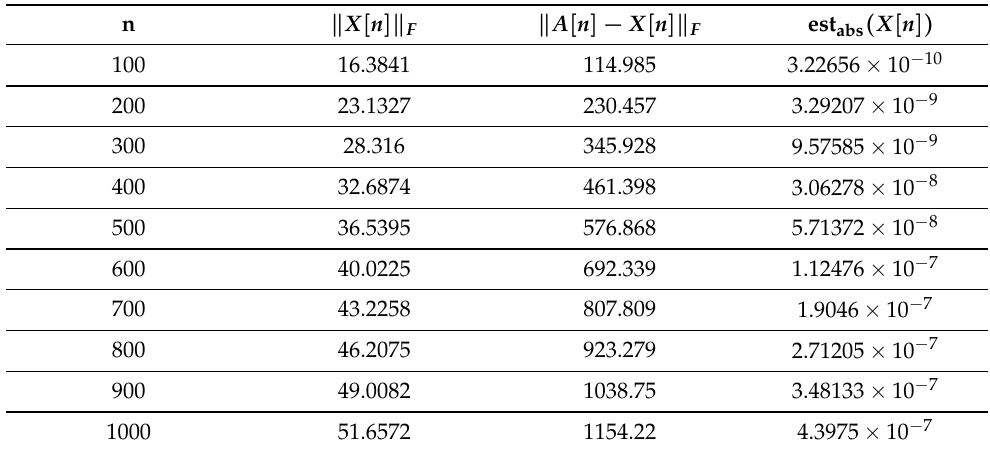
Table 1. Frobenius-norm errors in Example